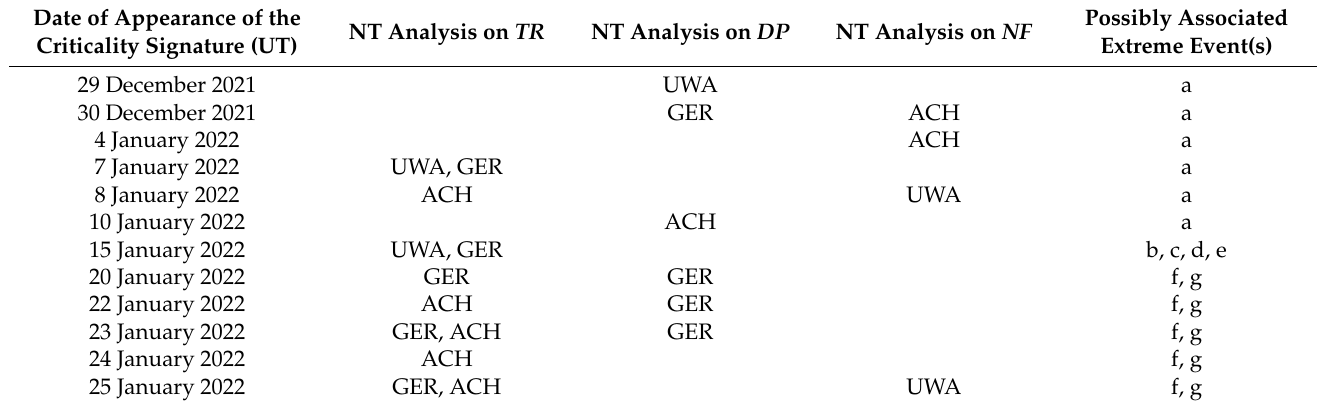
Figure 7. NT analysis of the TR VLF propagation quantity time series of the propagation path Figure 7. NT analysis of the 𝑇𝑅 VLF propagation quantity time series of the propagation path ISR– ACH for the examined period (18 December 2021 – 29 January 2022). The presented temporal vari- ISR–ACH for the examined period (18 December 2021–29 January 2022). The presented temporal ations of the NT parameters correspond to the di ff erent thresholds of 𝑇𝑅 (cid:3021)(cid:3035) : ( a ) 2, ( b ) 2.5, ( c ) 3, ( d ) variations of the NT parameters correspond to the different thresholds of TR Th : ( a ) 2, ( b ) 2.5, ( c ) 3, 3.5, respectively. The limit value of the entropy appears as a horizontal solid light green line, while ( d ) 3.5, respectively. The limit value of the entropy appears as a horizontal solid light green line, the value 0.07, along with the region around it, are denoted by a horizontal solid grey and two while the value 0.07, along with the region around it, are denoted by a horizontal solid grey and two horizontal dashed grey lines, respectively. The 〈𝐷〉 limit is shown as a horizontal brown line. The horizontal dashed grey lines, respectively. The (cid:104) D (cid:105) limit is shown as a horizontal brown line. The light green patch in each panel indicates the presence of criticality according to the conditions set light green patch in each panel indicates the presence of criticality according to the conditions set by by NT analysis. The events in each panel depend on the corresponding threshold. Moreover, alt- hough the conventional time (date) of occurrence of each corresponding event is noted in the x-axis NT analysis. The events in each panel depend on the corresponding threshold. Moreover, although tick values, the x-axis scale actually follows the NT representation; for this reason, the x-axis is not the conventional time (date) of occurrence of each corresponding event is noted in the x-axis tick linear in conventional time. Date format is day/month (for dates that belong to December the year values, the x-axis scale actually follows the NT representation; for this reason, the x-axis is not linear is 2021, while for January the year is 2022). in conventional time. Date format is day/month (for dates that belong to December the year is 2021, while for January the year is 2022). Table 8. Results of the NT analysis for the 2022 Cyprus EQ. UWA, GER, and ACH denote the station where the corresponding criticality has been identi fi ed. Table 8. Results of the NT analysis for the 2022 Cyprus EQ. UWA, GER, and ACH denote the station where the corresponding criticality has been